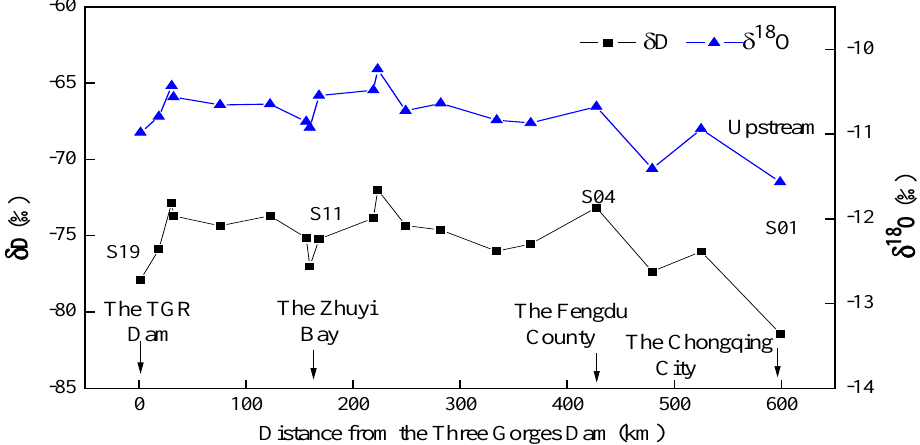
Figure 3. Spatial variation of the δD and δ 18 O stable isotopes along the TGR mainstream during the dry season (November 2015).